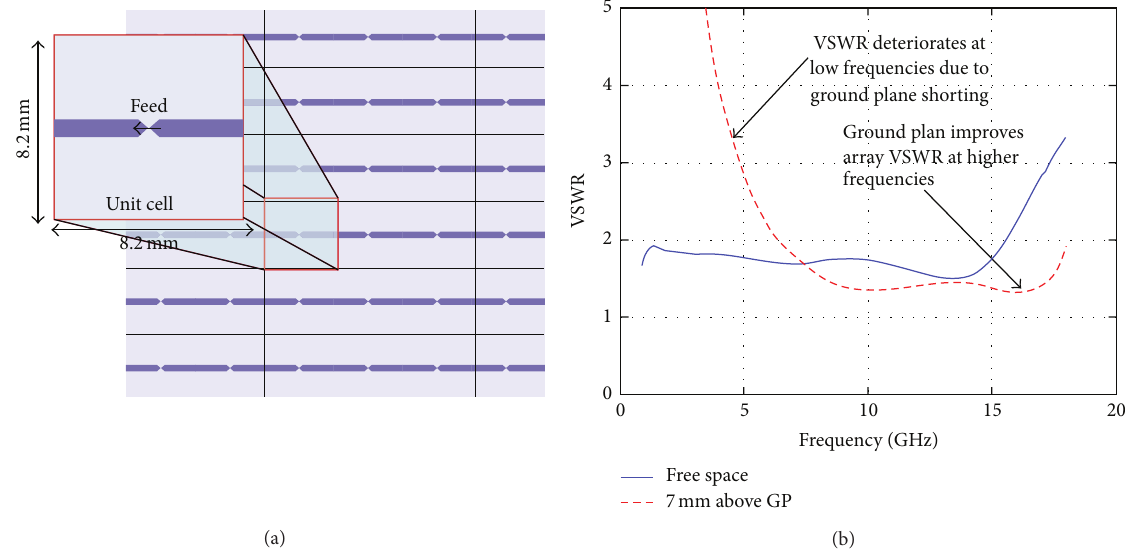
Figure 4: VSWR for a tightly coupled dipole array (TCDA) when radiating in free space or in presence of a metallic ground plane from